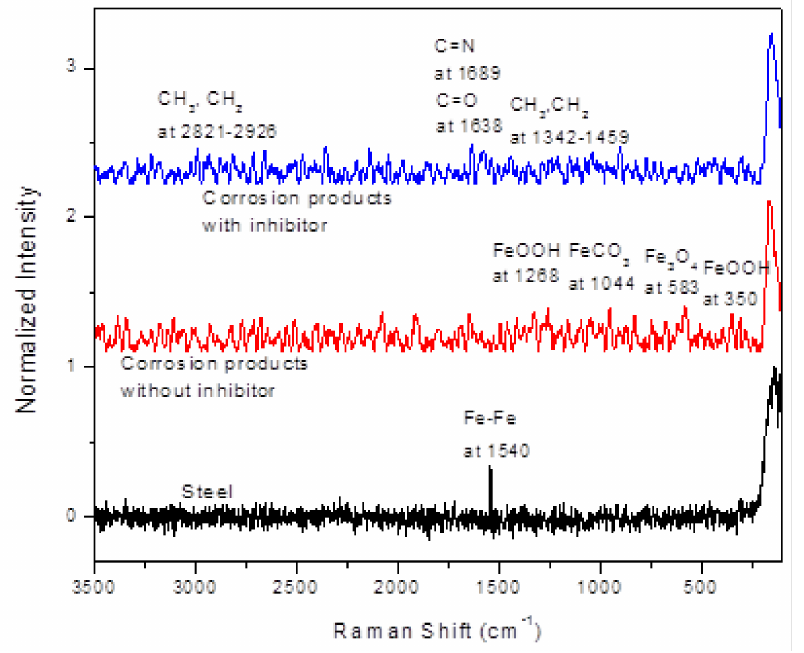
Figure 11. Raman spectrum of corrosion products formed on top of X-120 steel corroded in absence and presence of 100 ppm of gemini surfactant.